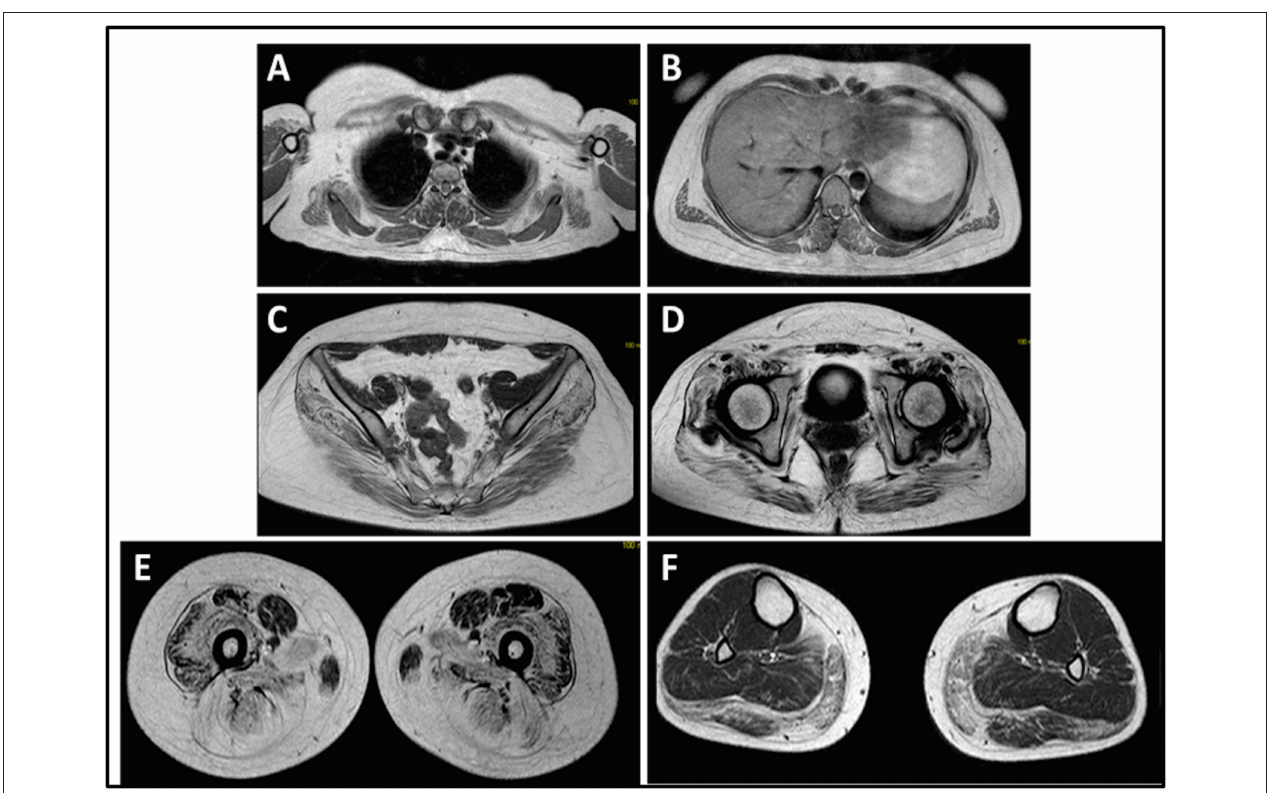
FIGURE 2 | Proband muscle MRI: involvement of upper limb girdle and paravertebral muscles (A,B) , involvement of lower limb girdle and posterior compartment of the thigh ( C–E , mostly the glutei) with relative sparing of the sartorius and gracilis, and involvement of the posterior compartment of the leg ( F , mostly gastrocnemius